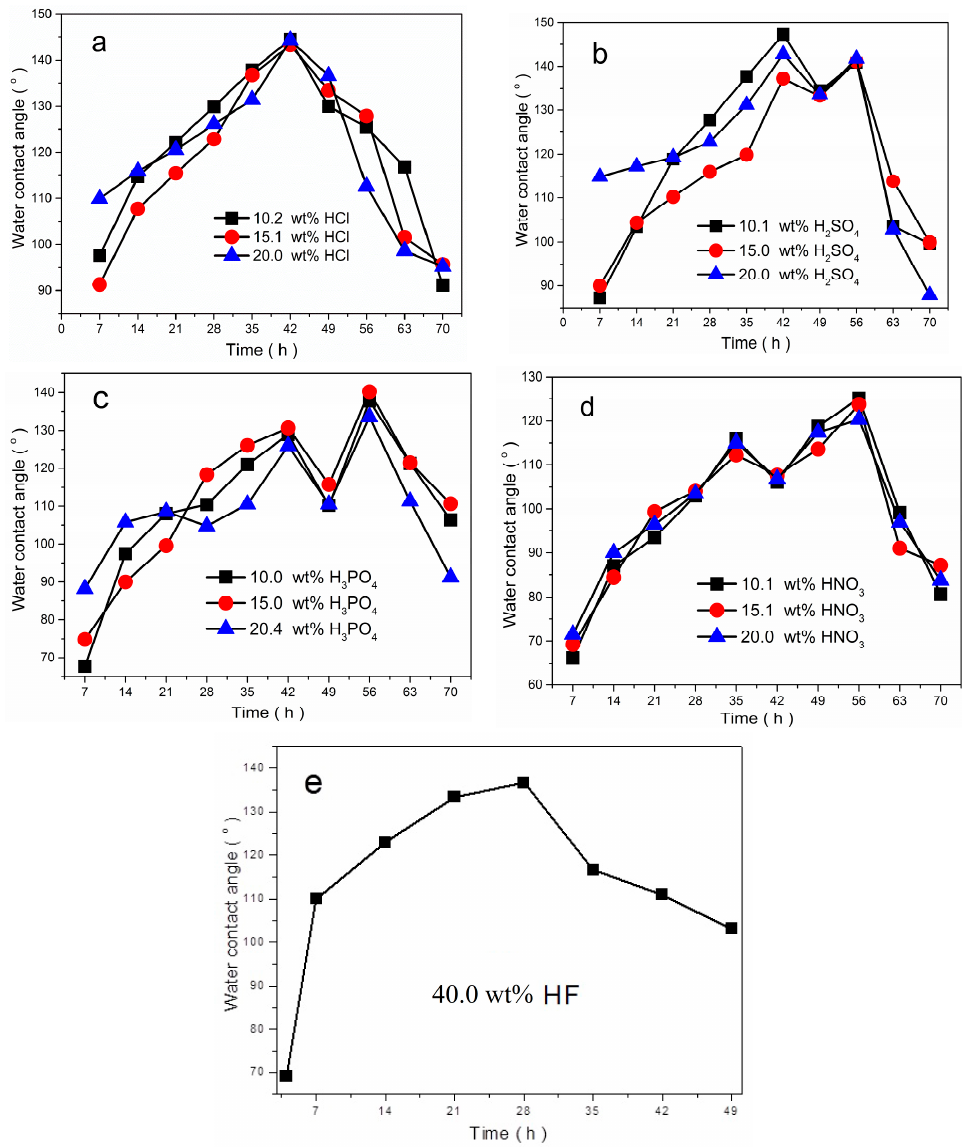
Figure 8. Variations in the SCAs on the etched Ni surfaces with the etching time: ( a ) etched by HCl; ( b ) etched by H 2 SO 4 ; ( c ) etched by H 3 PO 4 ; ( d ) etched by HNO 3 ; and ( e ) etched by HF.